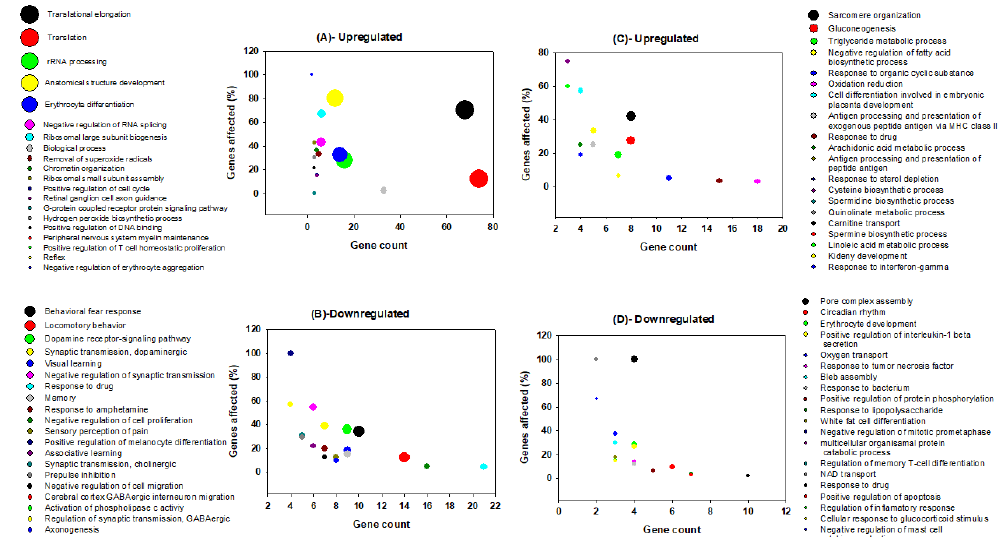
Figure 3. Graphical representation of GO terms from biological processes for genes that are up-regulated in the brain ( A ), down-regulated in the brain ( B ), up-regulated in the liver ( C ), and down-regulated in the liver ( D ) following rapid eye movements sleep deprivation in rats. The x -axis shows gene count, and the y -axis shows the percentage of genes affected for respective node. The bubble size represents the log transformed p -value [Y = −0.5*log(Y)] of the respective biological processes. A bigger bubble size indicates a more significantly affected given process, and thus, a lower p -value. The top 20 terms are displayed for each category.